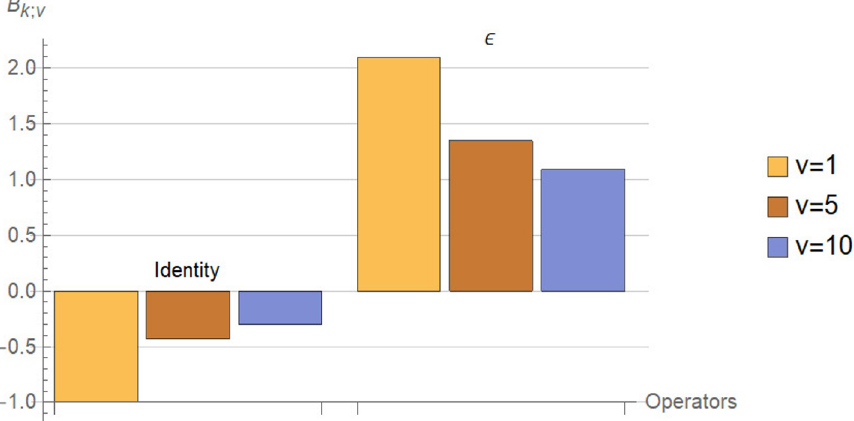
Figure 13 . Contribution of certain operators to the sum rule of h σσσσ i with the subtraction scheme ( k ) = (1 , 1 , 0 , 0) . Contribution of other operators are of order O (10 − 2 ) and 12 , k 23 , k 34 , k 14 less. The sum of all operators lead to 0 . 998 , 0 . 999 and 0 . 999 for the three values of v in the plot respectively.